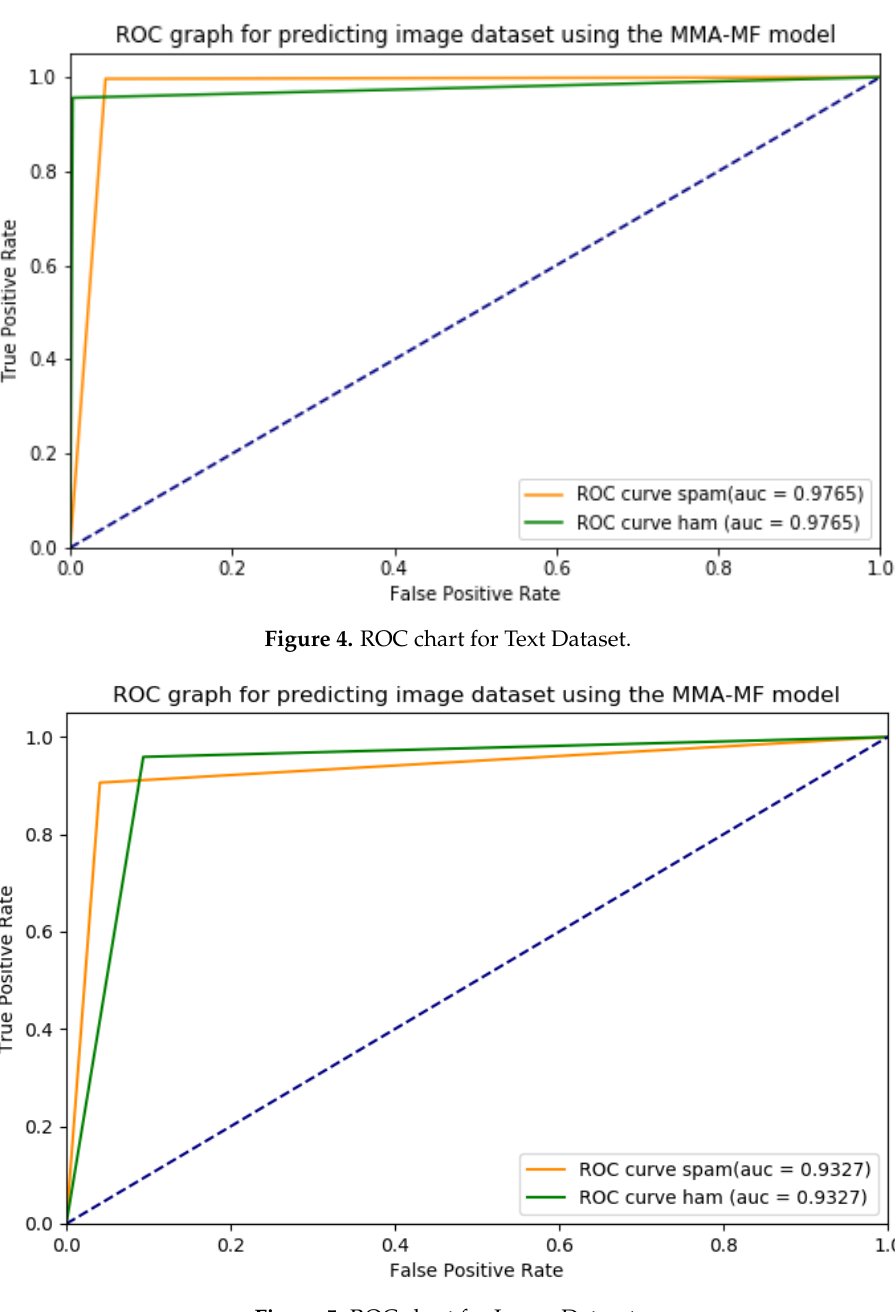
Figure 5. ROC chart for Image